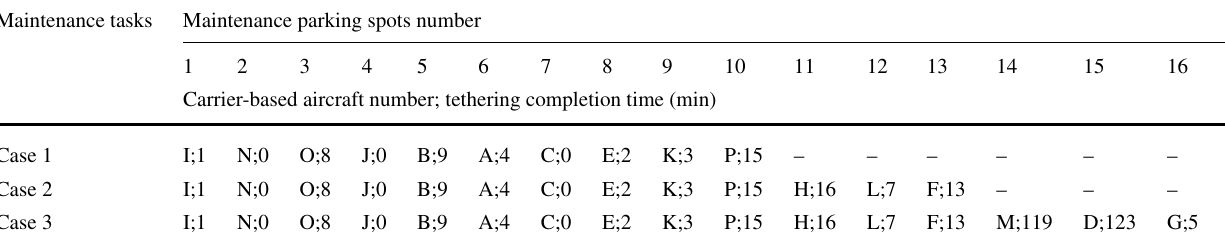
Table 2 Correspondence among carrier-based aircraft, maintenance parking spots, and time for tethering completion Maintenance